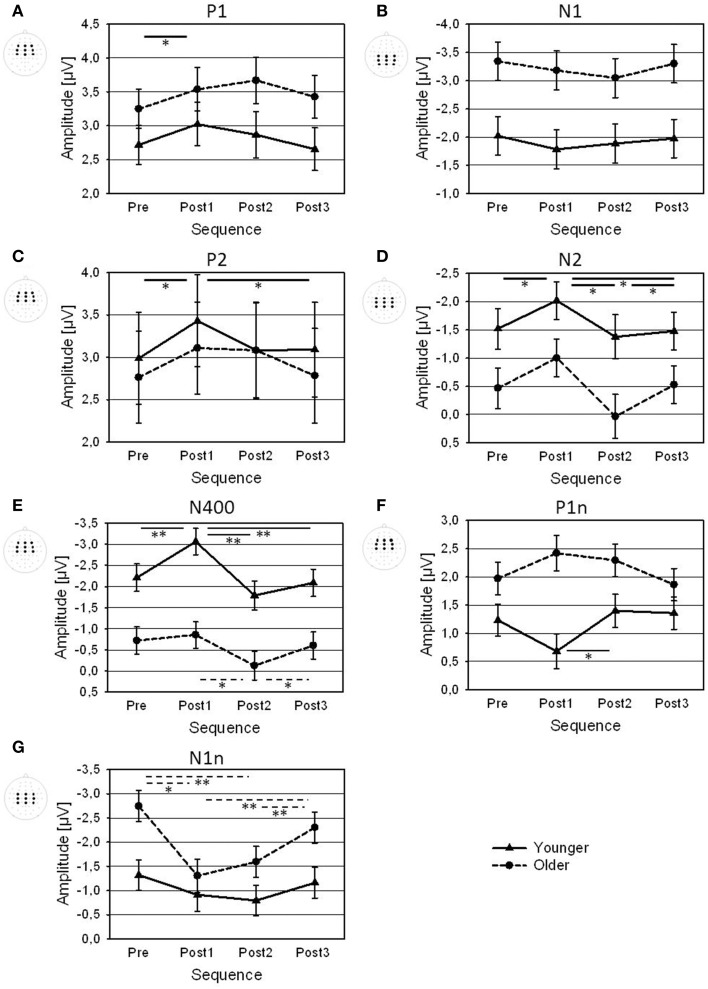
Amplitudes of (A) P1, (B) N1, (C) P2, (D) N2, (E) N400, (F) P1n, and (G) N1n (averaged across the displayed electrode arrays) for Pre, Post1, Post2, and Post3 sequences, shown for younger and older participants. Error bars are standard errors across participants (N = 22). Significance bars and asterisks indicate significant differences between sequences in the younger group (solid), in the older group (dotted), or averaged across both groups (bold; *p < 0.05; **p < 0.01).